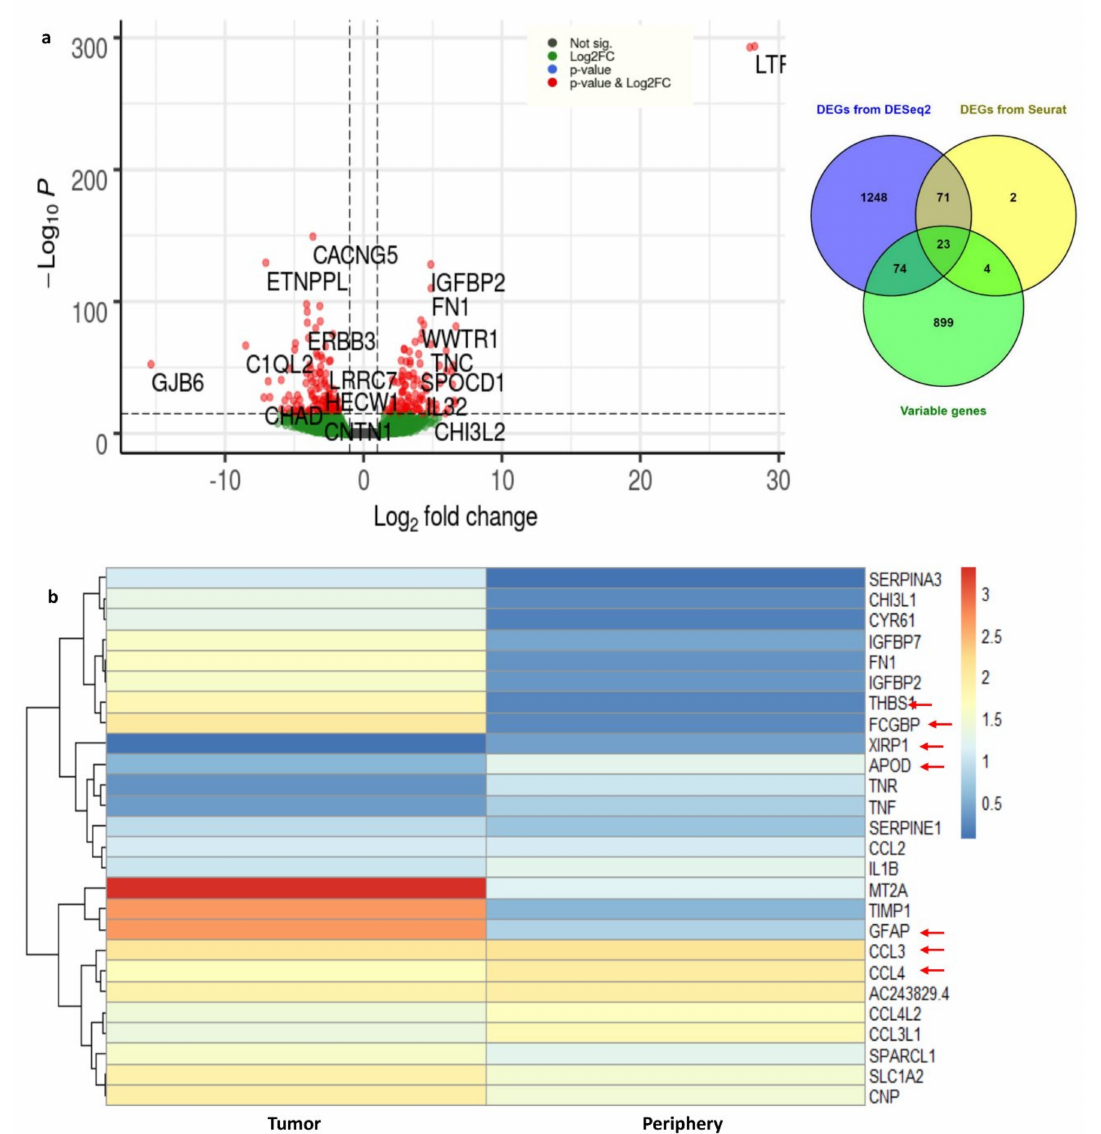
Figure 4. ( a ) Volcano plot for the differentially expressed genes from DESeq2. The up- and down- regulated genes with the cut-off of log2FC > 1 and with adj. p -value < 0.05 are shown in the figure. ( b ) The heat map representation for the important DEGs and their expression rates in tumor and periphery core